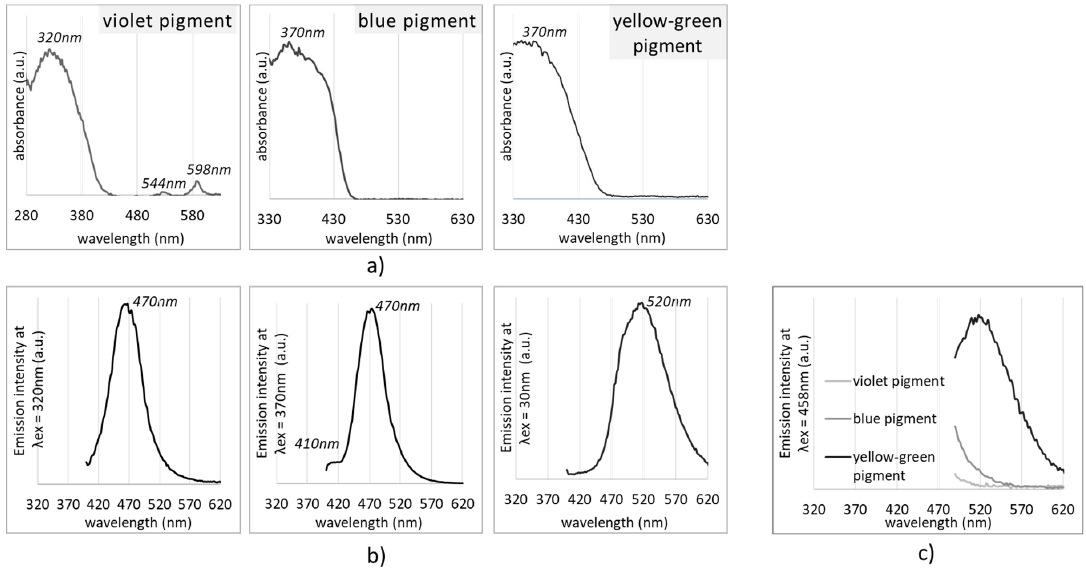
Figure 3. Absorption ( a ) and emission spectra at λ ex = 370 nm ( b ) and λ ex = 458 nm ( c ) of violet, blue and yellow green pigments. Spectral lines are normalised at maximum intensity.